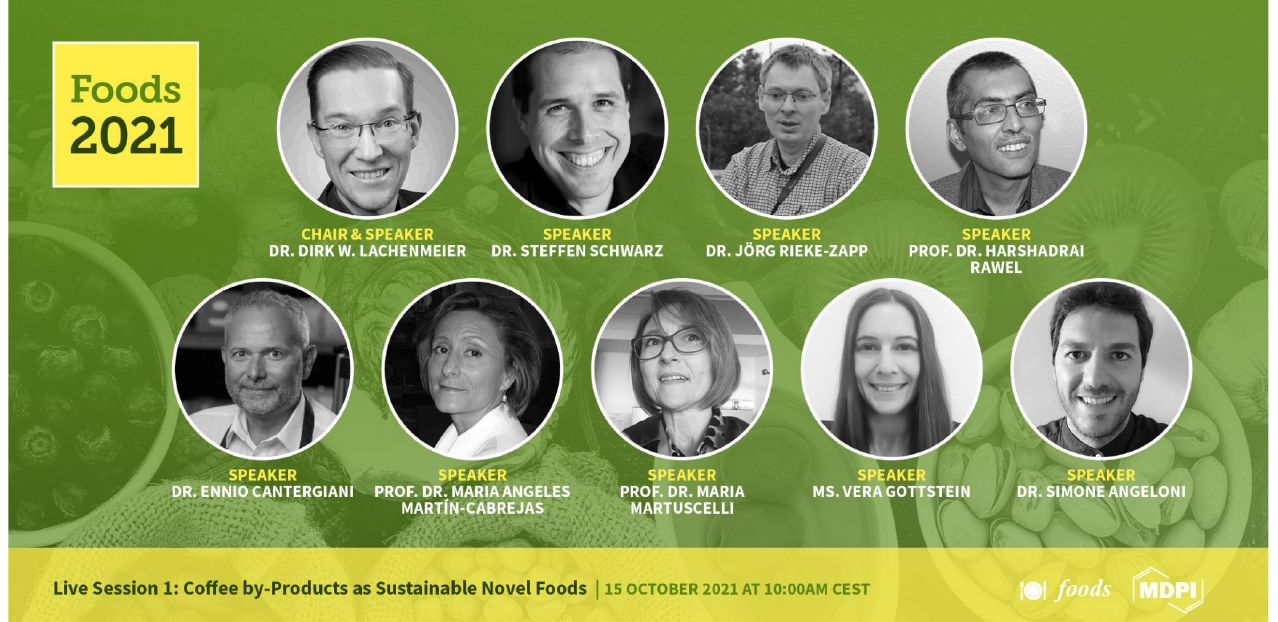
Figure 1. Speakers of the Foods 2021 Conference live session 1 on coffee by-products.